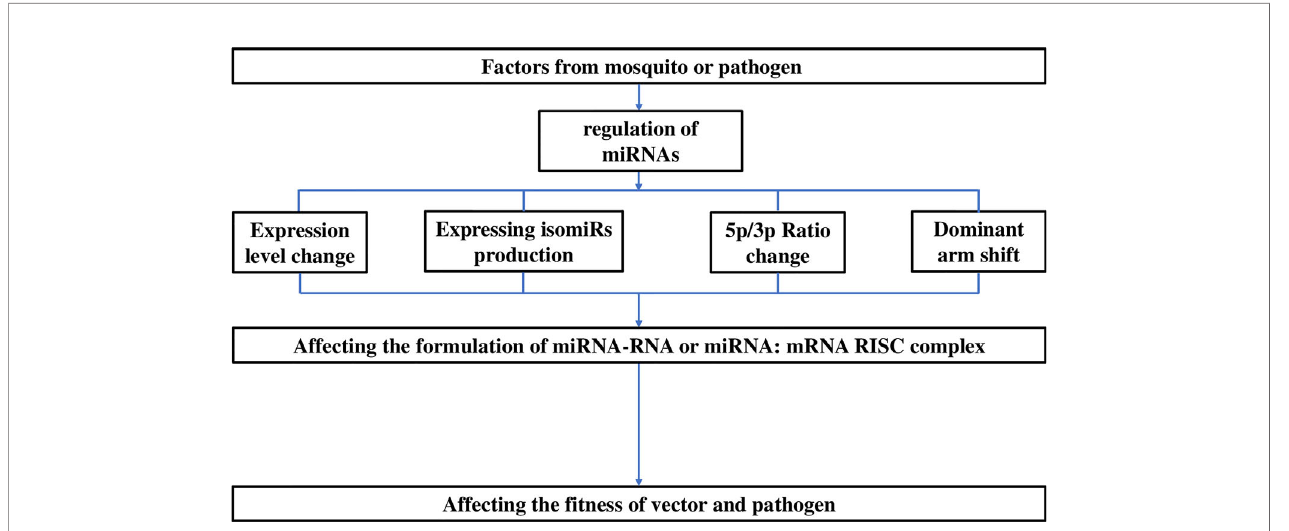
FIGURE 2 | Responses of miRNAs to characteristics of mosquitoes or pathogens and subsequent miRNA-pathogen interactions in mosquitoes. The responses involve modi fi cations in the expression level, isomiR production, or 5p/3p ratio or shift in dominant arm, and any of these alterations can affect the fi tness between the vector and pathogen. During modi fi cation by miRNAs, the functional component is the formation of the miRNA-target RISC complex. For arboviruses, the complex can be composed of miRNAs and the virus genome (miR-RNA complex) in mosquitoes, directly regulating pathogen infection; however, for Plasmodium parasites, it is always composed of miRNAs and mosquito immunity-related mRNAs (miR-mRNA complex), indirectly regulating the